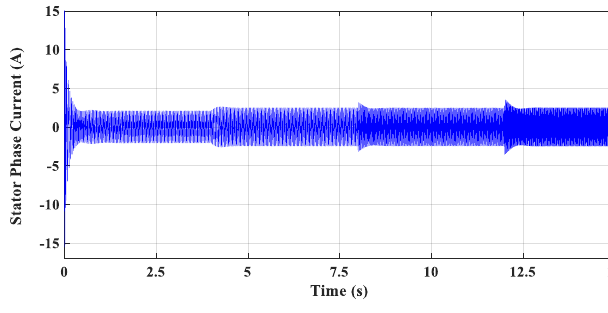
Figure 9. Stator phase-current response.